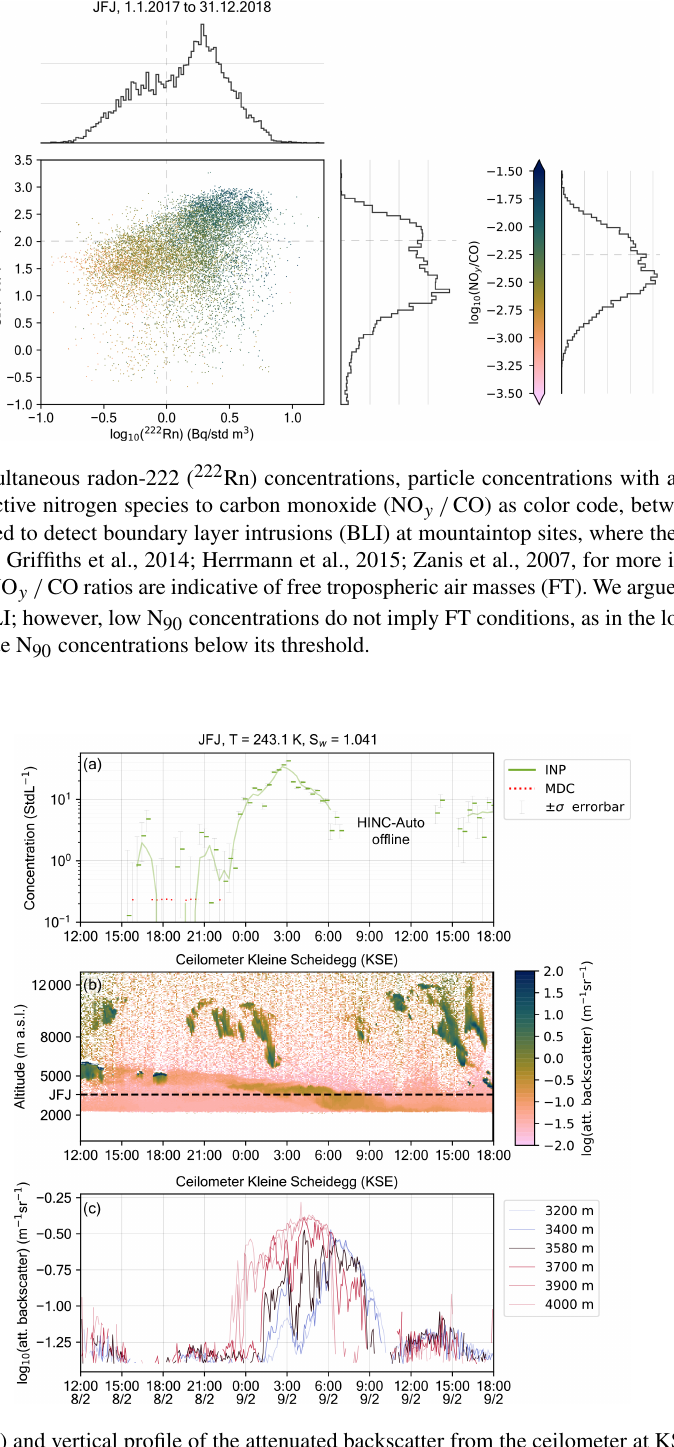
Figure A4. INP concentrations ( a ) and vertical profile of the attenuated backscatter from the ceilometer at KSE ( b ) and at selected altitudes similar to the altitude of JFJ with filtering for signals in cloud and in precipitation ( c ) during a classified dust event, starting on 8 February, 23:29UTC, and ending on 9 February, 06:00UTC. When an INP measurement is below the minimum detectable concentration (MDC) of 0.236INPstdL − 1 , a red dashed marker is plotted. On 9 February, between 07:00 and 13:00UTC, HINC-Auto was not sampling INPs, but other classification and calibration measurements were performed, e.g., the particle loss rates through the sampling line as shown in Appendix